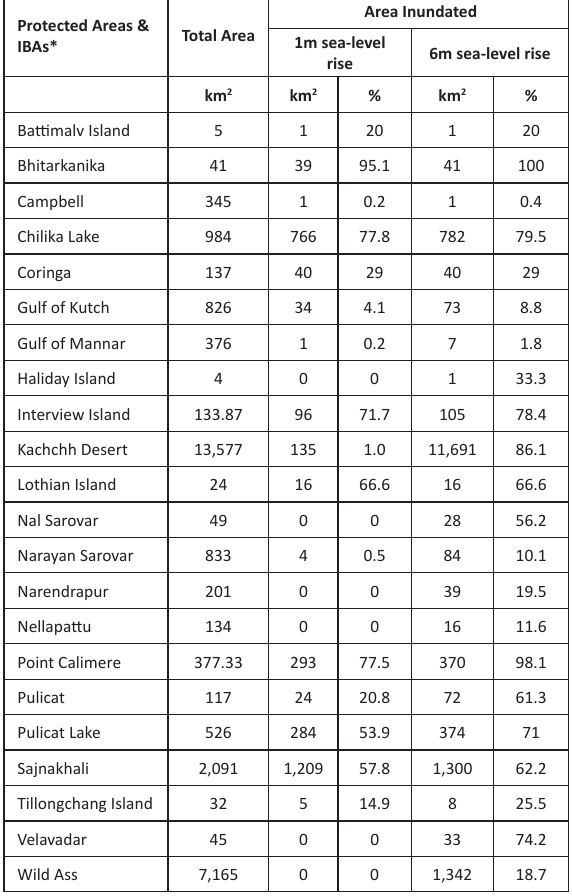
Table 3. Extent of selected conservation areas (PAs and IBAs) inundated by marine intrusion as a result of 1m and 6m sea-level